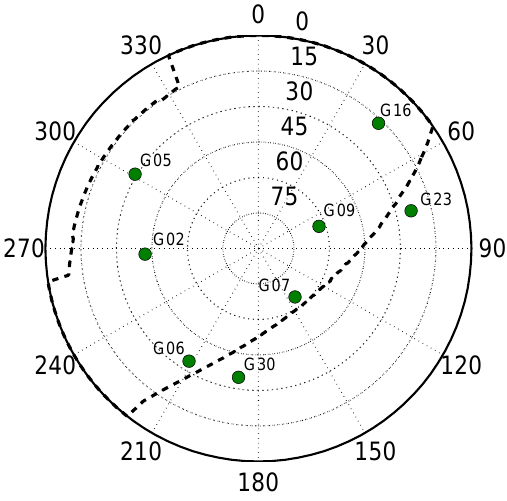
Figure 6. Skyplot of test point #22. The black dashed line represent the OAEM determined for this initial antenna position.